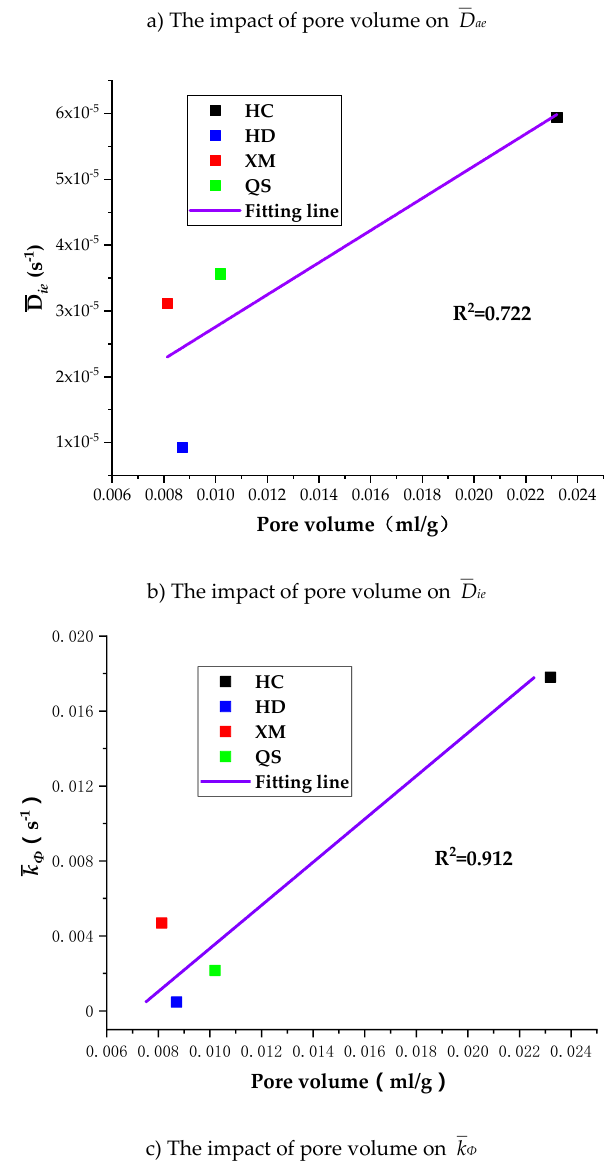
Figure 12. The impact of pore volume on D ae , D ie and k Φ.